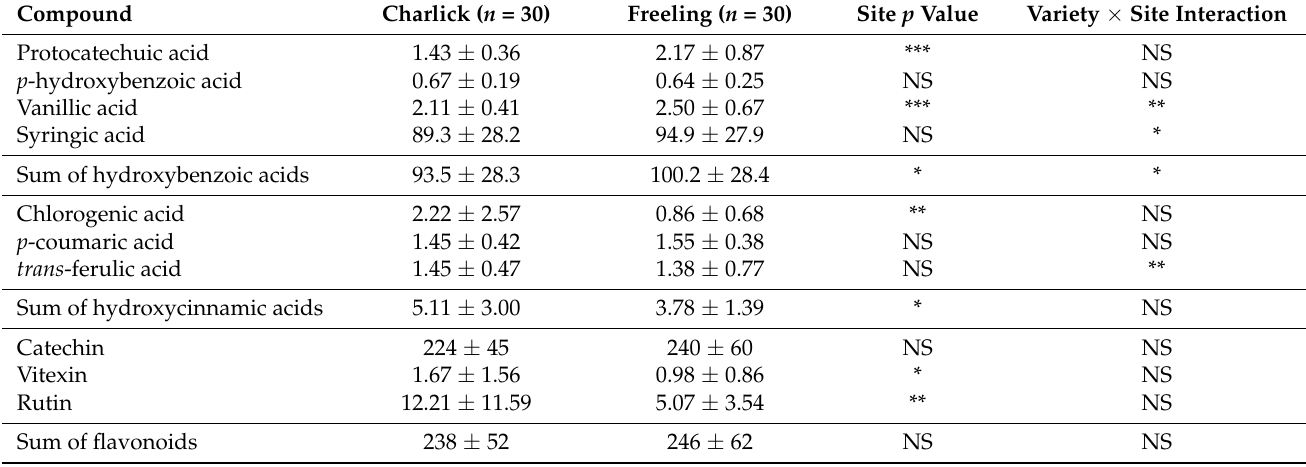
Table 2. Impact of the growing site on phenolic acid and flavonoid contents. Values given in µ g/g (mean ± SD from 3 replicates for each location). The p -value column indicates the significance between sites, with results obtained from a two-way ANOVA between site ×